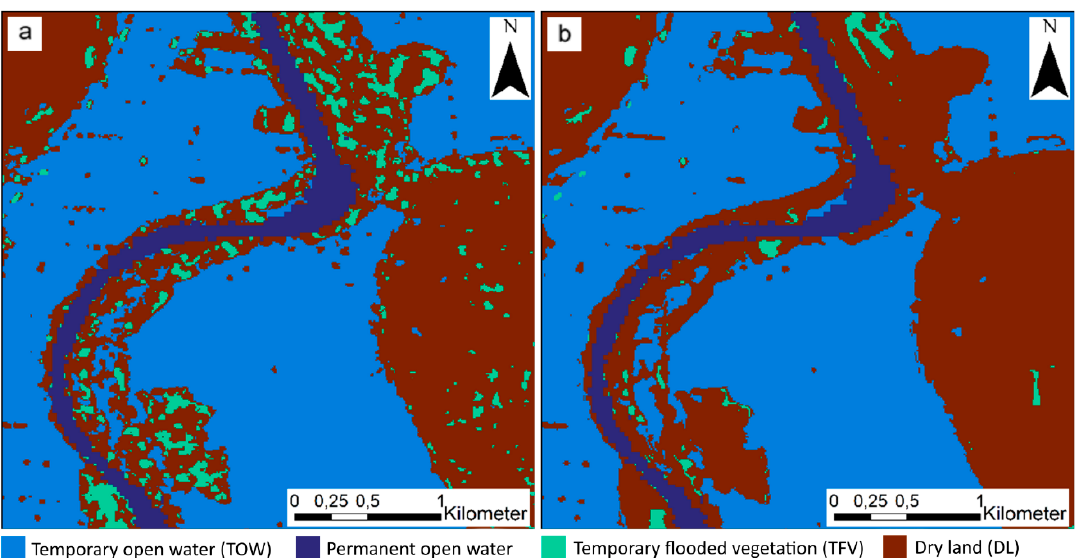
Figure 11. Pixel-based classification result ( a ) and object-based classification result ( b ) for the study area in northern Greece/Turkey.